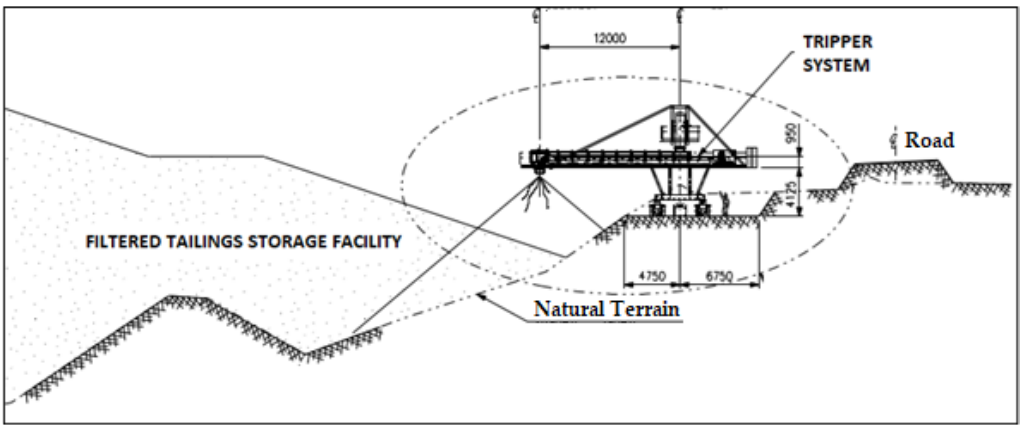
Figure 7. Typical View of Filtered Tailings Facility using Conveyor Belt and Tripper System [23].